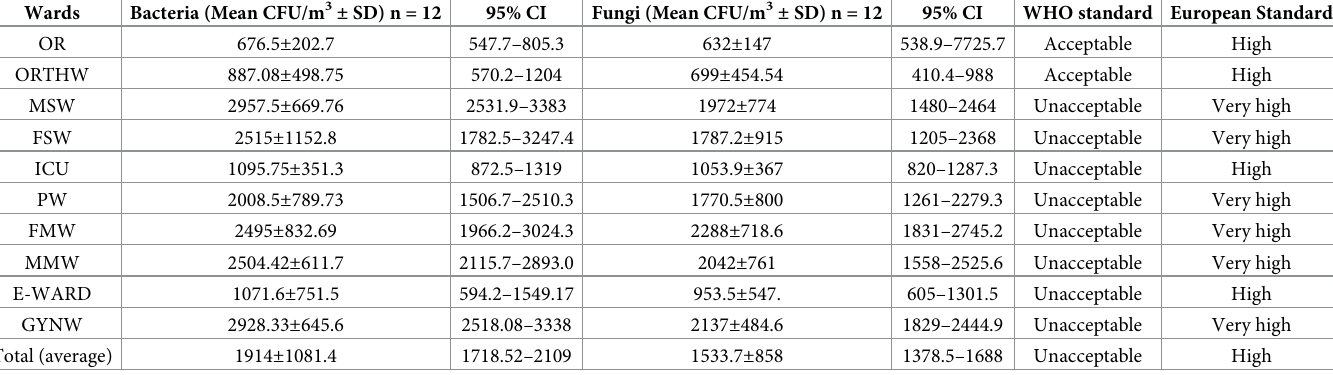
Table 1. Average means of microbial load of different wards in the AMGH versus the WHO expert group and European commission sanitary standards for non- industrial premises. Wards Bacteria (Mean CFU/m 3 ± SD) n =